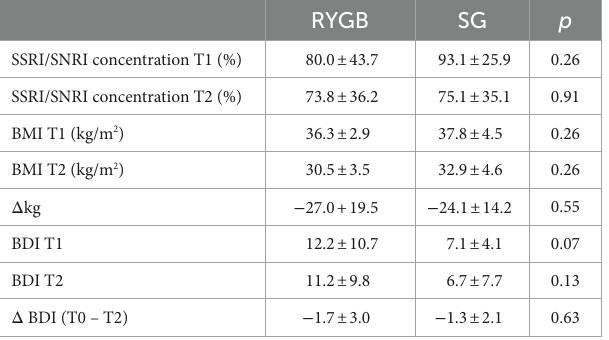
TABLE 2 Comparison of clinical outcome in patients undergoing bariatric surgery: laparoscopic Roux-en-Y gastric bypass (RYGB) ( n = 20) vs. sleeve gastrectomy (SG) ( n =